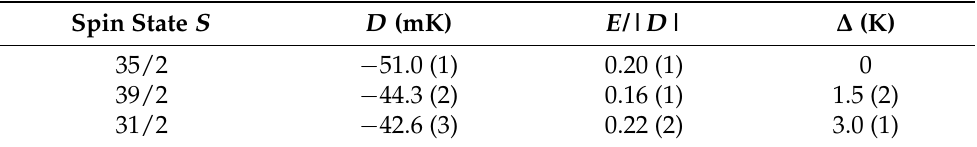
Figure 5. The Q dependence of the scattering intensity measured at 35 mK with an incident neutron energy of ( a ) 5.15 meV, showing bands II, III, and IV, and ( b ) 2.00 meV, showing band I. Table 6. Parameters for the ground state and two lowest lying excited states obtained from a global fit of the temperature dependent inelastic neutron spectra (Figure 4c). The data were analysed with the zero field version of the model Hamiltonian, Equation (4). The offset of the minimum energy of the excited state with respect to the S = 35/2 ground state is shown in the final column as the excitation gap ∆